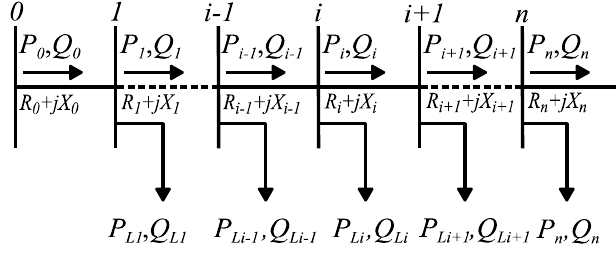
Figure 4. Simple radial distribution system.